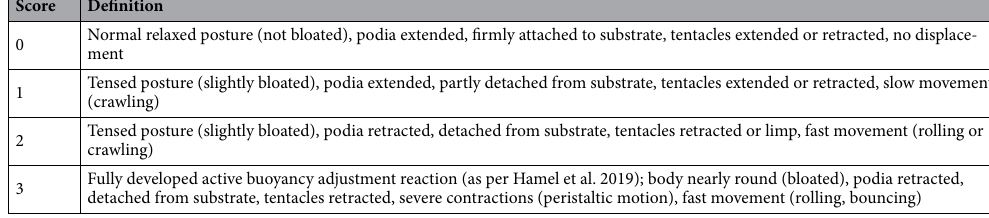
Table 1. Behavioural scores used in the study of Cucumaria frondosa